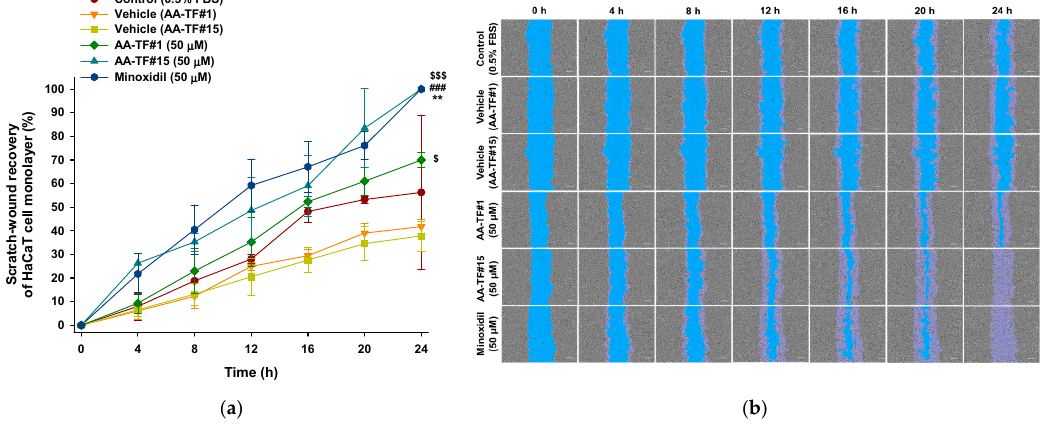
Figure 4. In vitro assay for determination of relative scratch-wound recovery of HaCaT cells incu- bated with 1% atraric acid (AA) topical formulations (AA–TF#1 and AA–TF#15), 1% minoxidil in ethanol (EtOH), or vehicles of AA–TF#1 or #15 diluted to a drug concentration equivalent to 50 µM: ( a ) Time-course curve of relative scratch-wound recovery area of HaCaT cell monolayers. ** p < 0.01 compared to control (0.5% FBS); ### p < 0.001 compared to vehicle (AA–TF#1); $ p < 0.05, $$$ p < 0.001 compared to vehicle (AA–TF#15). Values represent mean ± SD ( n = 4); ( b ) Representative microscope images of scratch-wounds of HaCaT cells. Scale bar = 200 µm.